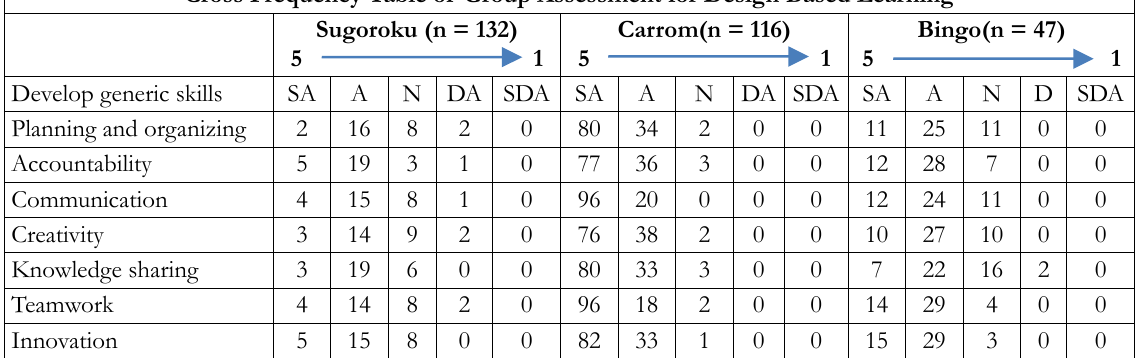
Table S1: Total responses from the participants for development of generic skill while playing board games to learn SDGs